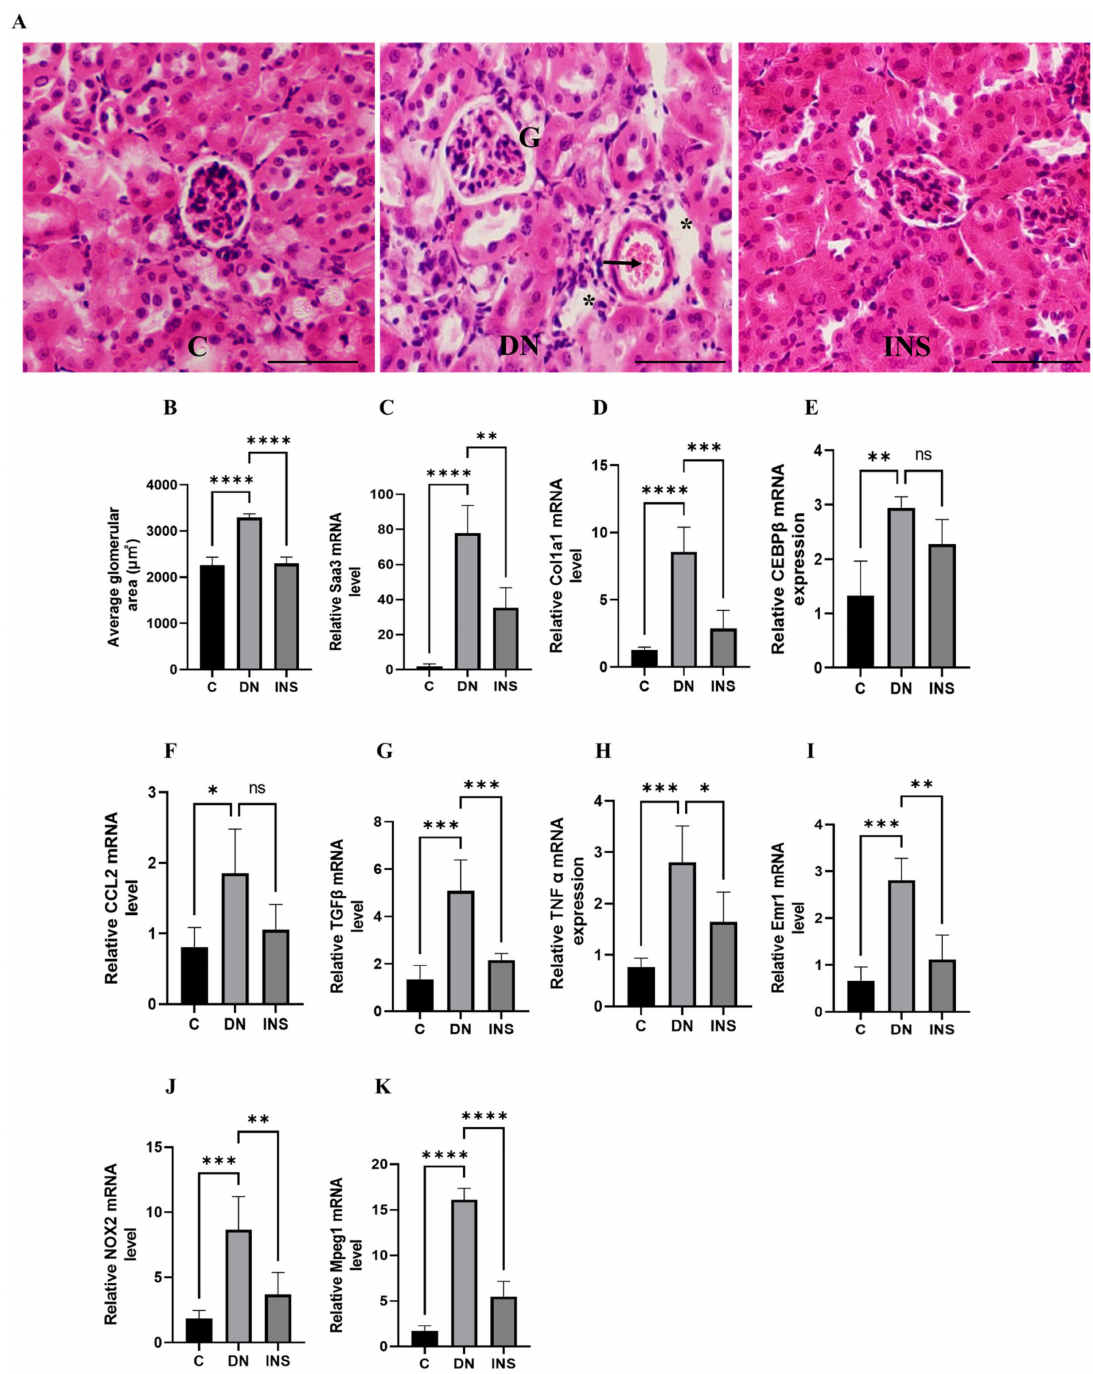
Figure 5. Validation of bioluminescence signals of Saa3 promoter-luc mice with traditional diagnostic tech- niques and ameliorative effect of insulin therapy on renal fibro-inflammatory cues in two-moderate-dose STZ-induced DN model. ( A ) Representative image of the kidney histological staining with H&E reagents. Glomerular hypertrophy, glomerular hypercellularity (G), brush border disruption (asterisks), and interstitial hemorrhage (arrow) were significantly increased in renal tissue of DN mice. Scale bar = 200 µ m. ( B ) Quantifica- tion of average glomerular size ( n = 5). ( C – K ) Kidney gene expression analysis of fibro-inflammatory markers in two-moderate-dose STZ-induced DN model ( n = 5). The relative mRNA expression level of each gene was determined by quantitative PCR and normalized to L19 mRNA level and are presented as means ± S.E. * p < 0.05, ** p < 0.01, *** p < 0.001, **** p < 0.0001 as determined by ANOVA followed by Dunnett’s test; ns: statistically not significant. DN = Diabetic Nephropathy, C = Control, INS = Insulin